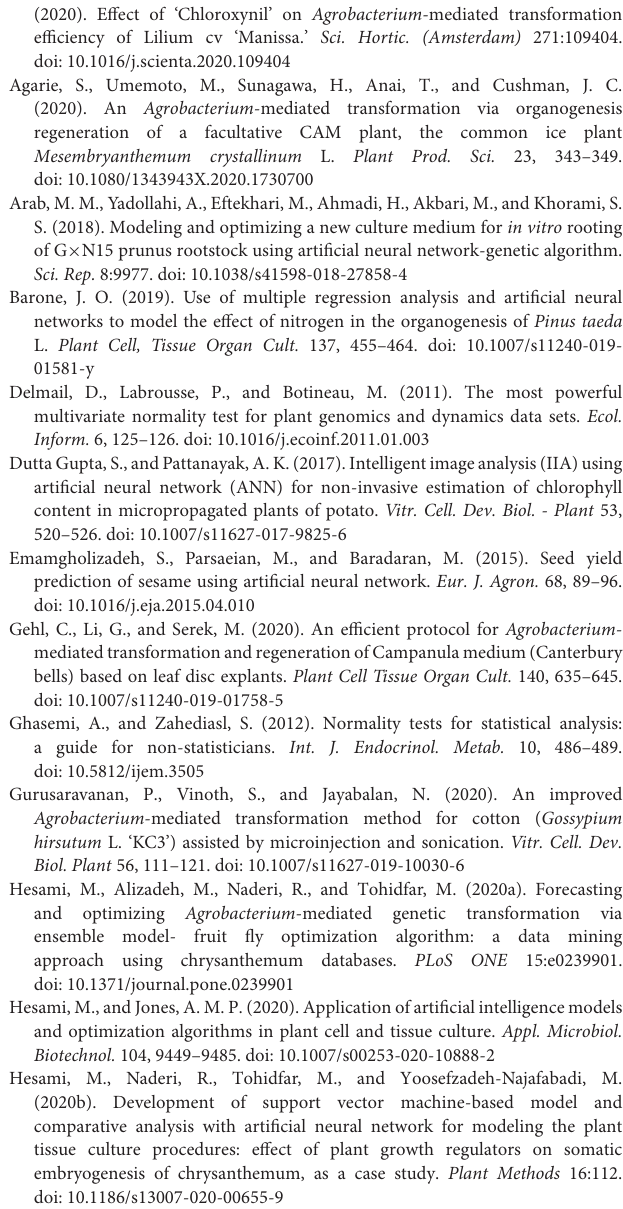
tabacum ) for resistance against cotton leaf curl disease complex. J. Virol. Methods 276:113760. doi: